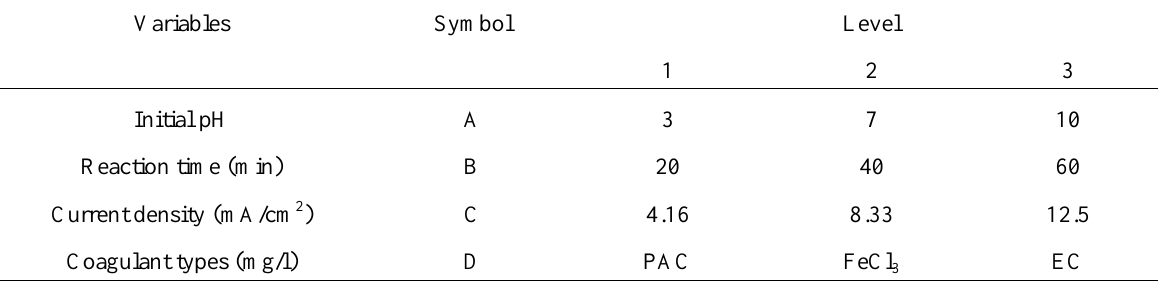
Table 1. Experimental range and levels of independent parameters in Taguchi design. Variables Symbol